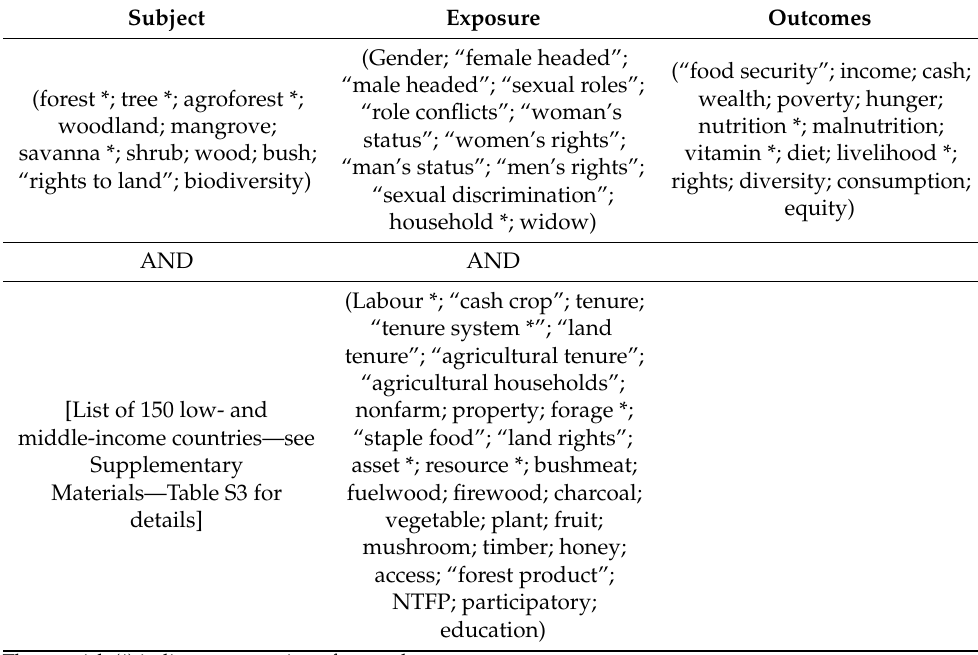
Table 2. Terms used to search for relevant